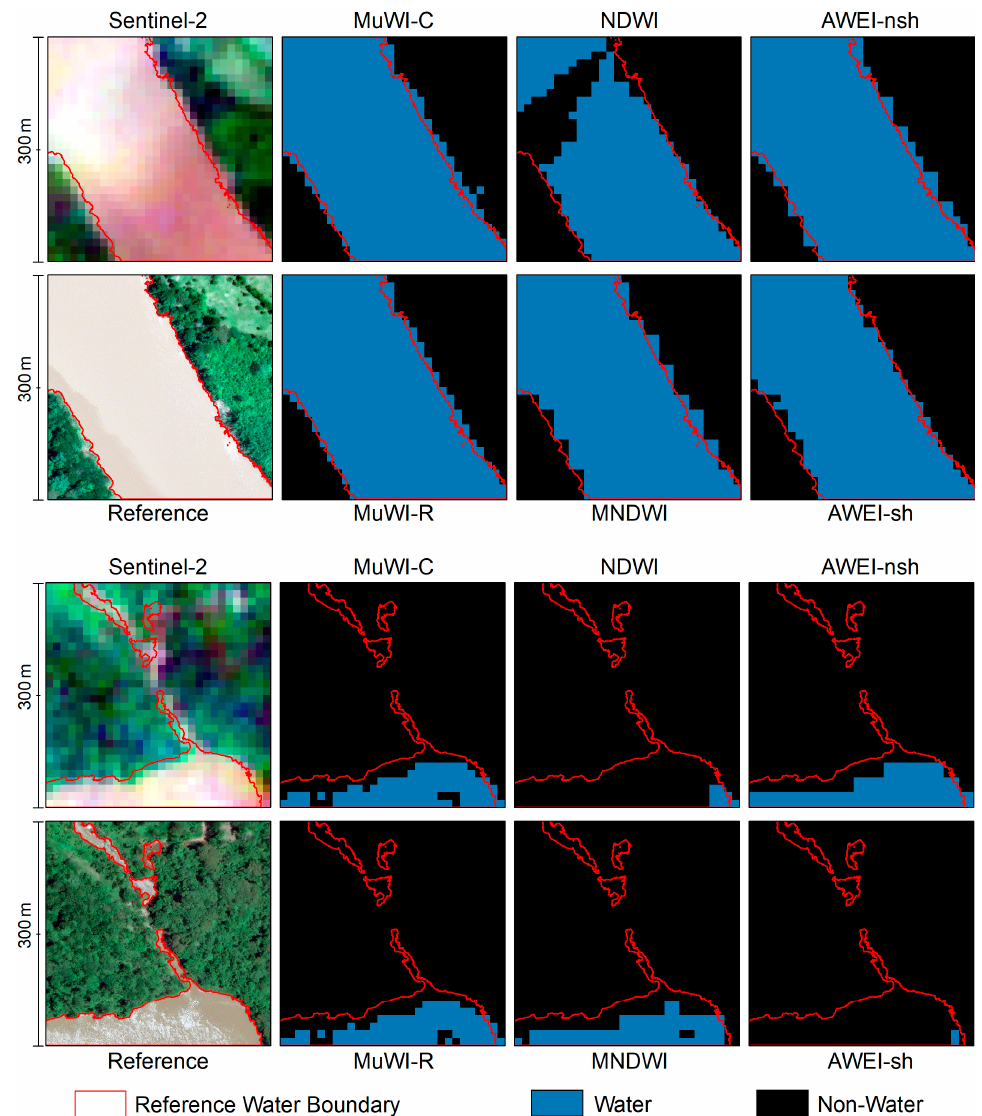
Figure 6. Two reference sites with suspected sunglint contaminations at a confluence ( top ) and an oxbow ( bottom ) of the inland river. The first column shows 10-m Sentinel-2 RGB image and 0.5-m reference RGB image. Column 2, 3, and 4 shows the water mapping results by six water index (MuWI-C, MuWI-R, NDWI, MNDWI, AWEI-nsh, AWEI-sh).